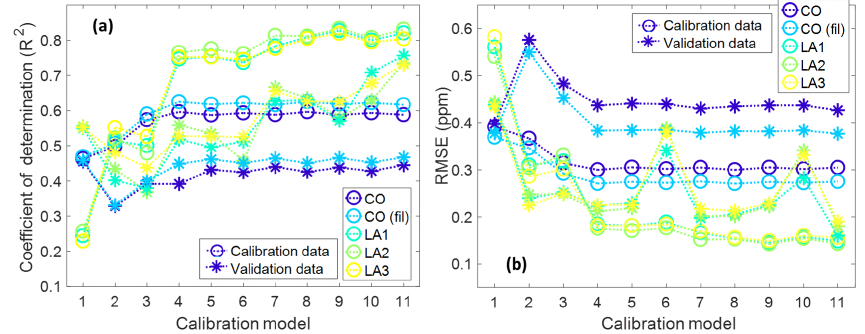
Figure 7. Plotted R 2 (a) and RMSE (b) for all models; circle markers indicate results from calibration generation (using the training data) and asterisk markers indicate results from the application of the models to the validation data (or testing data).